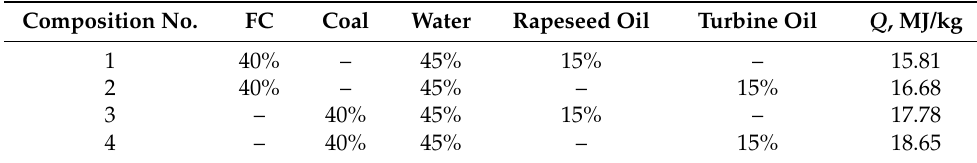
Table 1. Compositions of composite fuels and their caloric values.